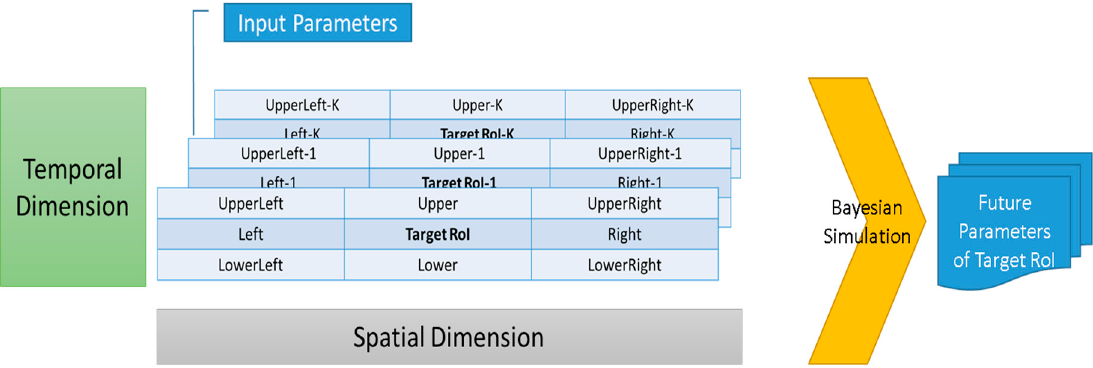
Figure 11. The windowing process.